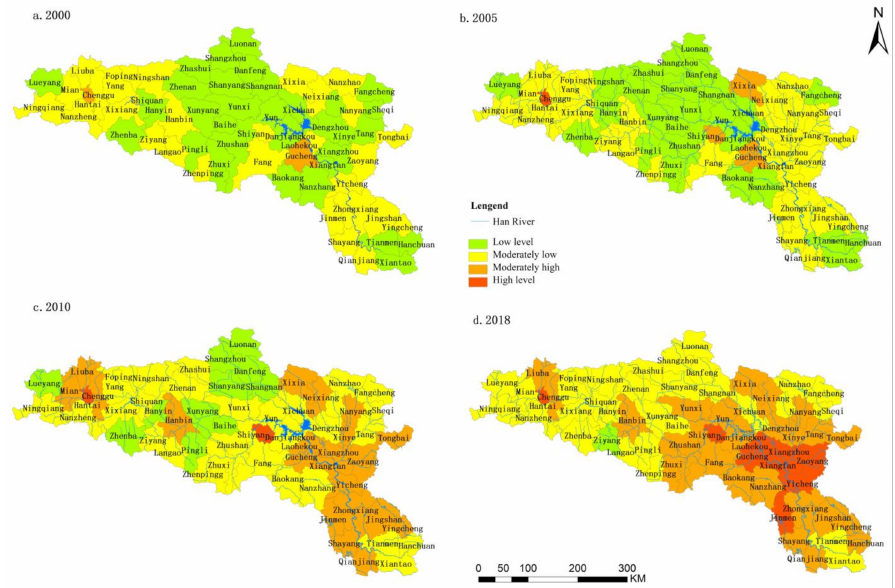
Figure 3. Spatial change trend of LUMF. The ( a – d ) stand for 2000, 2005, 2010, and 2018 respectively. Low level indicates that the indices of the three subsystems were all lower than the average value of the whole basin. Moderately low level indicates that any one of the three subsystem indices was higher than the average value of the whole basin. Moderately high level indicates that any two indices of the three subsystems were higher than the average value of the whole basin. High level indicates that the indices of the three subsystems were all higher than the average value of the whole